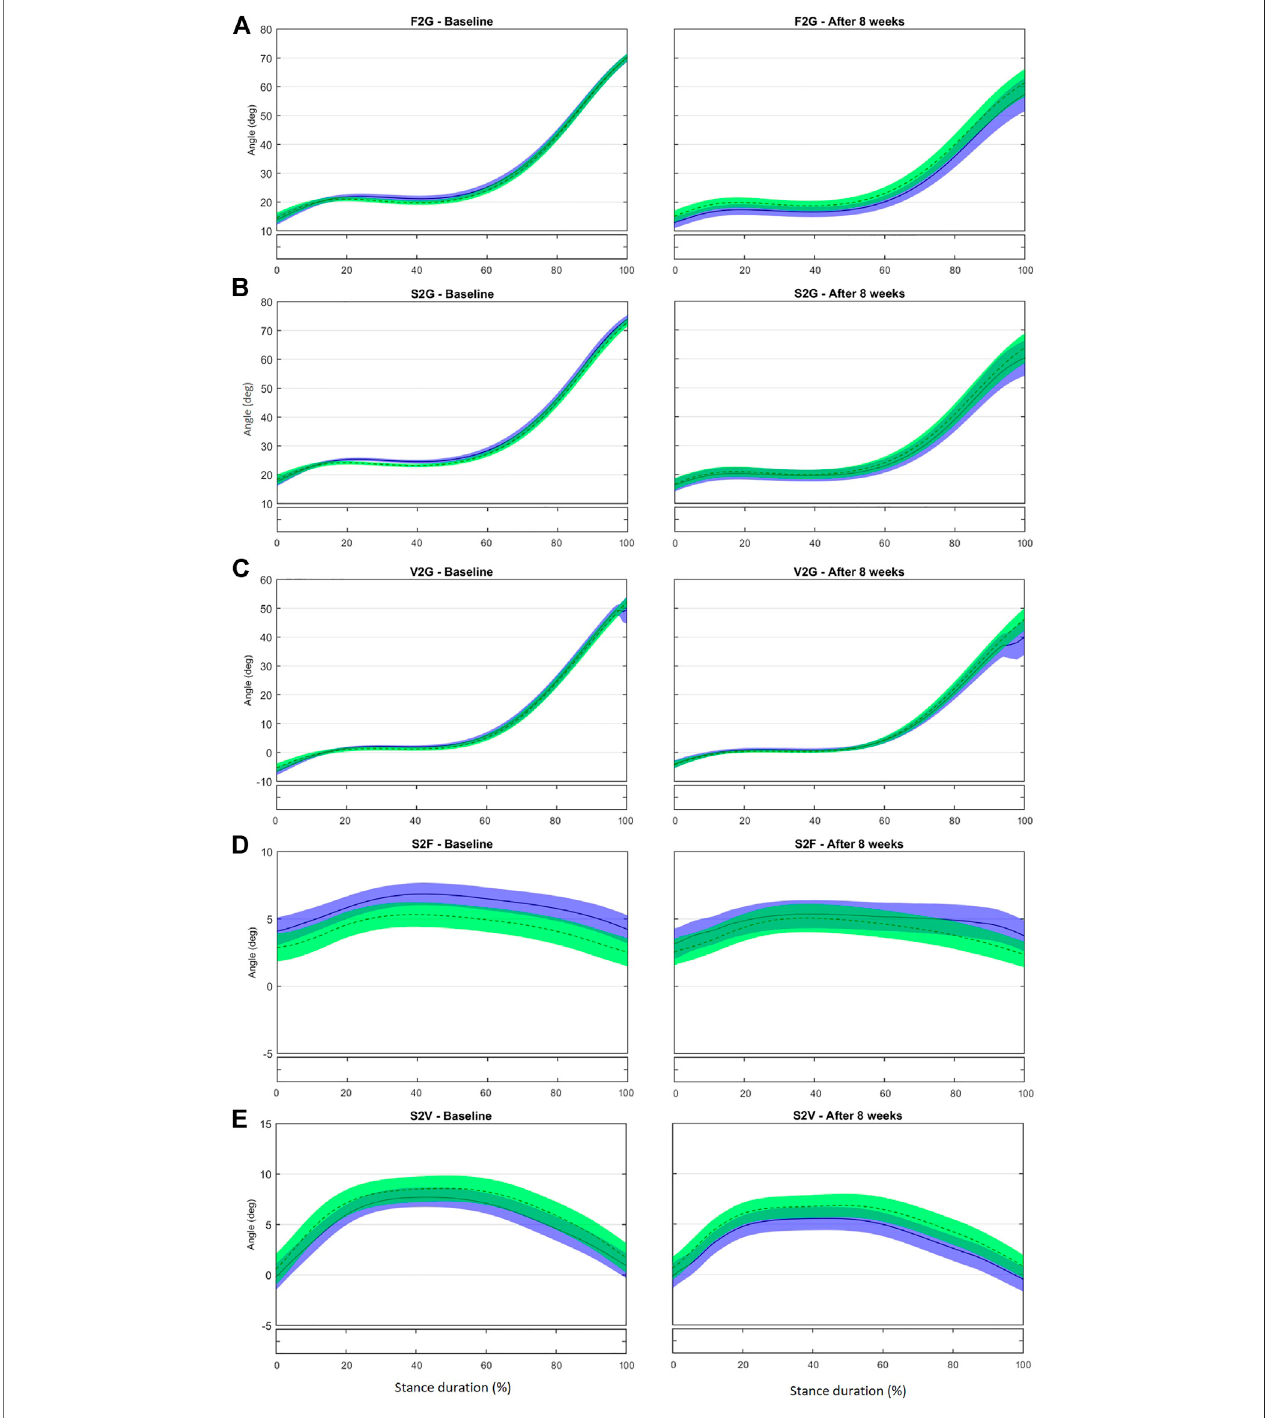
FIGURE2| Mean(±1SD)jointrotationanglesduringnormalizedstancephasedurationofrunninginthebaseline(left)andafter8 weeksofintervention(right).From toptobottom:Sagittal-planeinclinationofthe fi rstmetatarsalbonetotheground (A) ,ofthesecondmetatarsalbonetotheground (B) ,andofthe fi fthmetatarsalboneto theground (C) ;transverse-planedivergencebetween fi rstandsecondmetatarsalbones (D) andbetween fi fthandsecondmetatarsalbones (E) .Green,CGgroup;Blue, IGgroup.Theblackbarbelowthegraphrepresentsthetime duringwhichthedifferences betweenthegroupsoccurred( p < 0.05),whatwasindicatedbytheSPM {t}